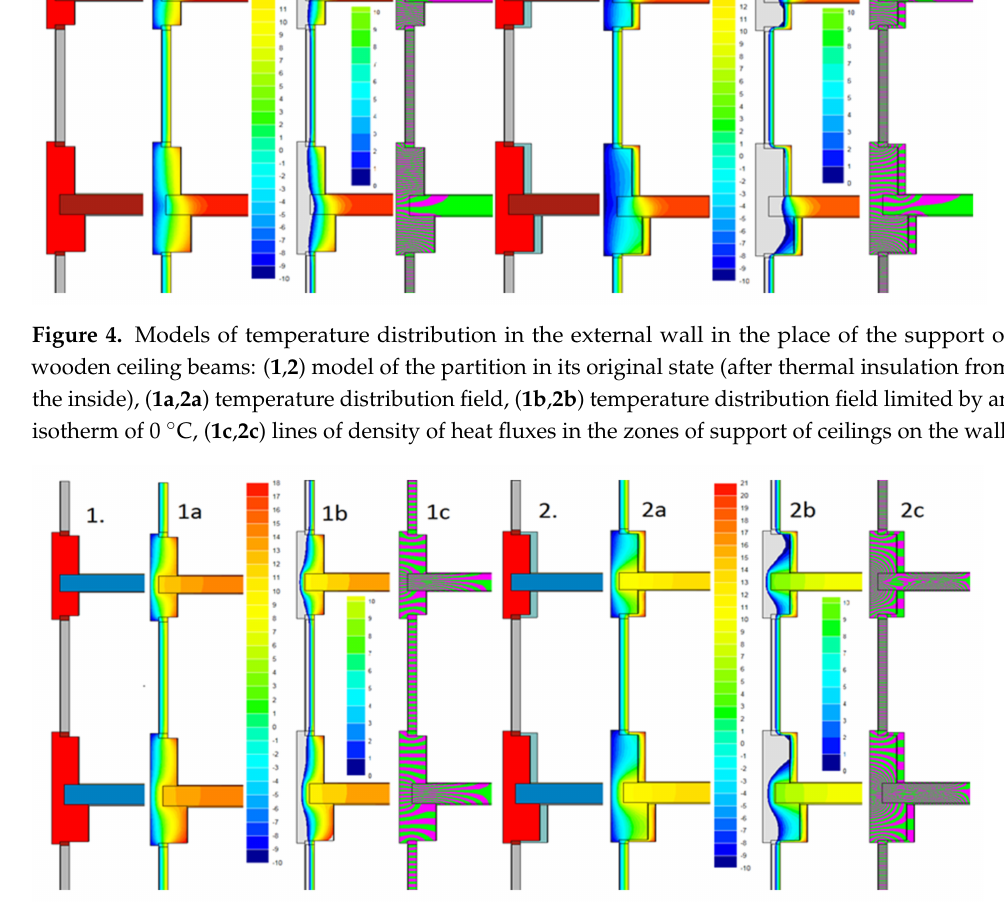
Figure 5. Models of temperature distribution in the external wall, in place of the support of iron or steel ceiling beams: ( 1 , 2 ) model of the partition in its original state (after insulation from the inside), ( 1a , 2a ) temperature distribution field, ( 1b , 2b ) temperature distribution field bounded by an isotherm of 0 ◦ C, ( 1d , 2d ) lines of density of heat fluxes in the zones of support of ceilings on the